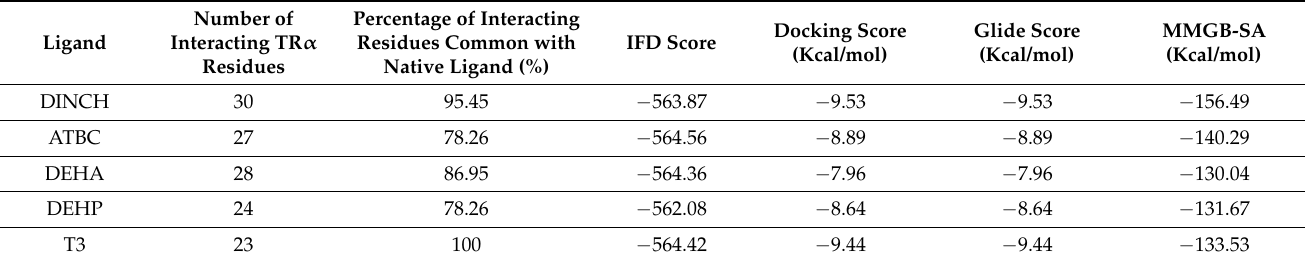
Table 1. Structural binding indices of plasticizers diisononyl hexahydrophthalate (DINCH), acetyl tributyl citrate (ATBC), di-(2-ethylhexyl) adipate (DEHA), di (2-ethylhexyl) phthalate (DEHP), a thyroid receptor (TR α ) native ligand, and triiodothyronine